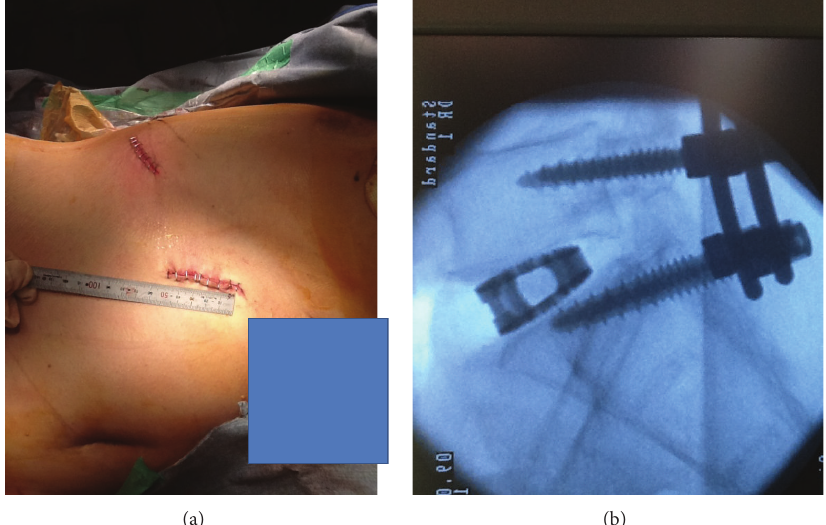
Figure 3: (a) Sutured skin after approaching L5-S1 and harvesting the iliac bone. (b) X-ray image after